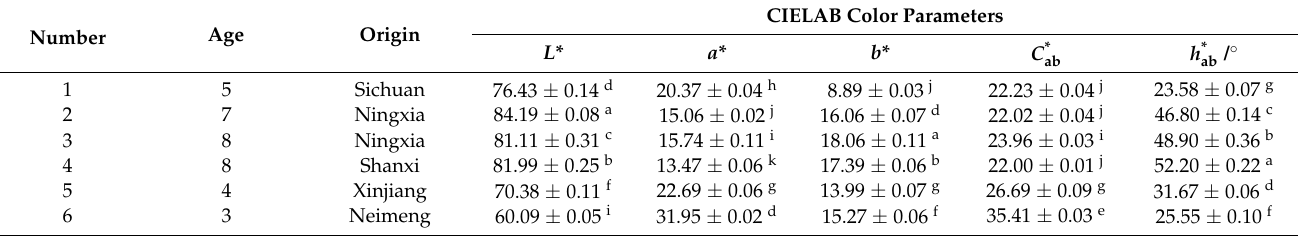
Table 1. CIELAB color parameters of red wine samples used for representation and